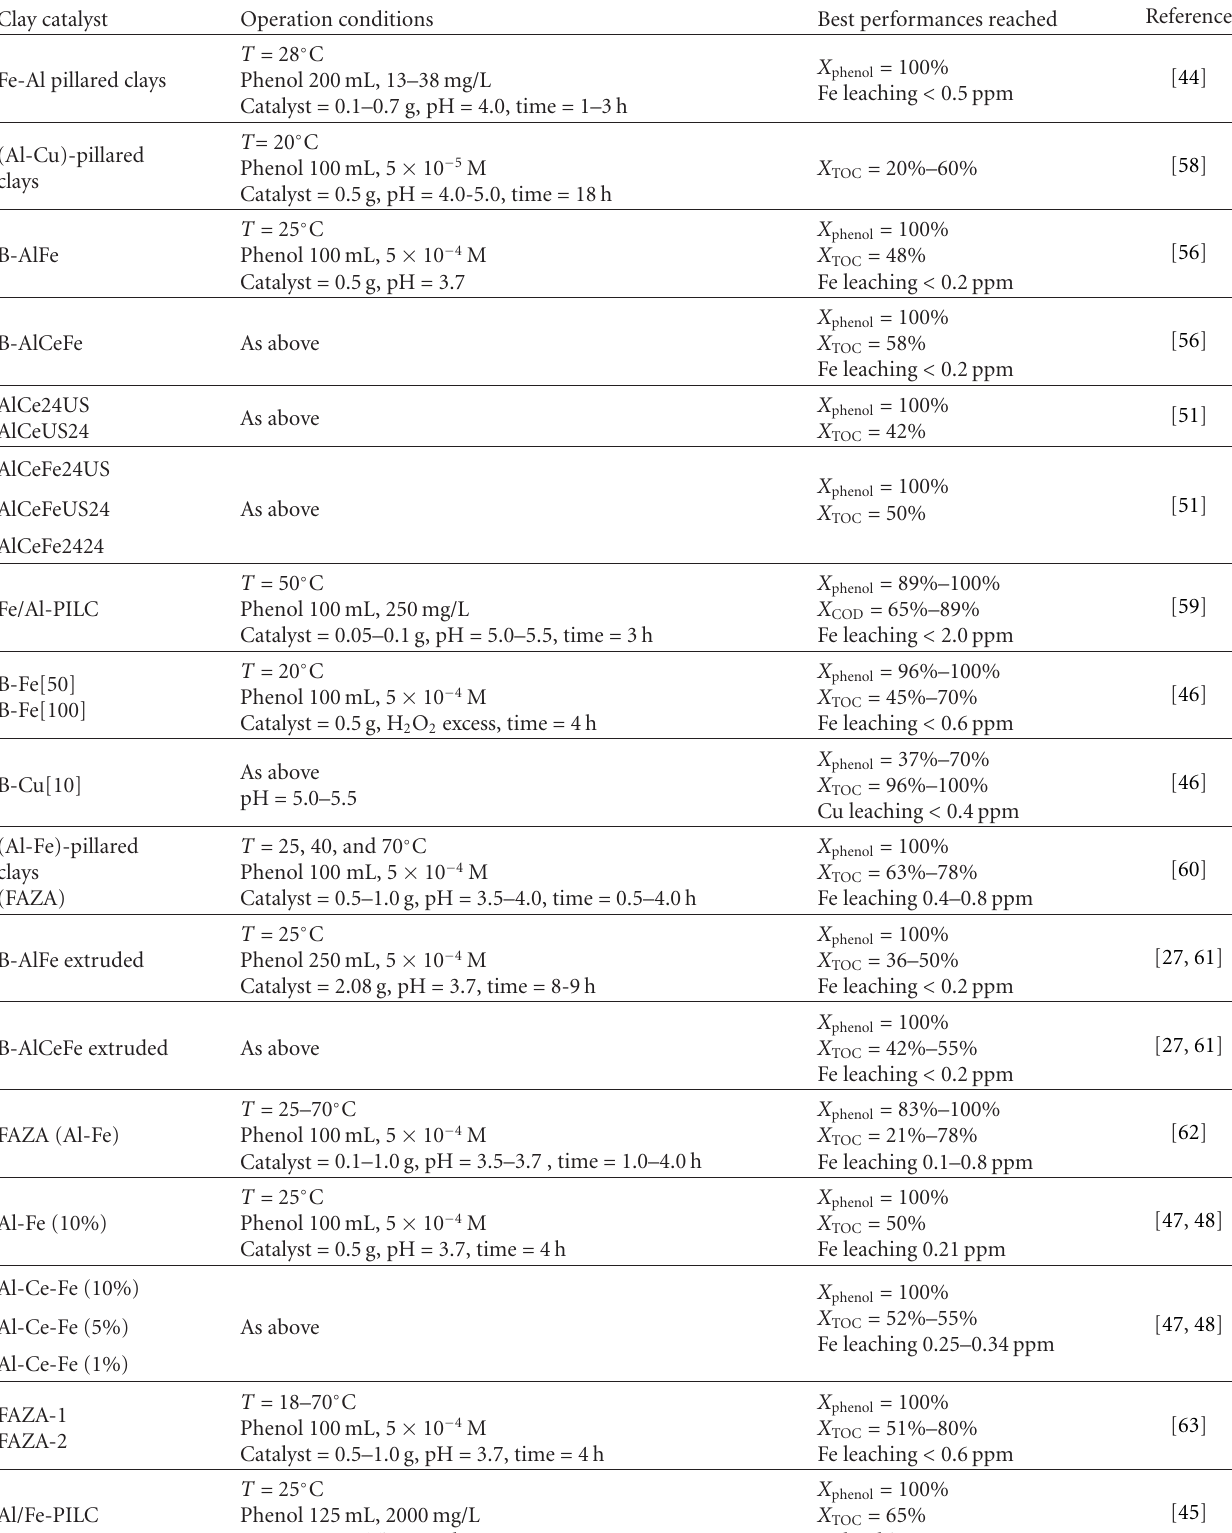
Table 2: Some examples of pillared clays-based catalysts for wet hydrogen peroxide oxidation of phenol. Clay